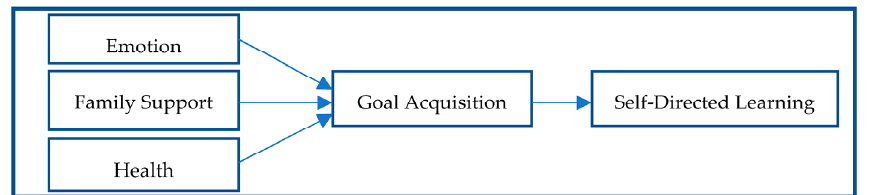
Figure 1. Conceptual framework.